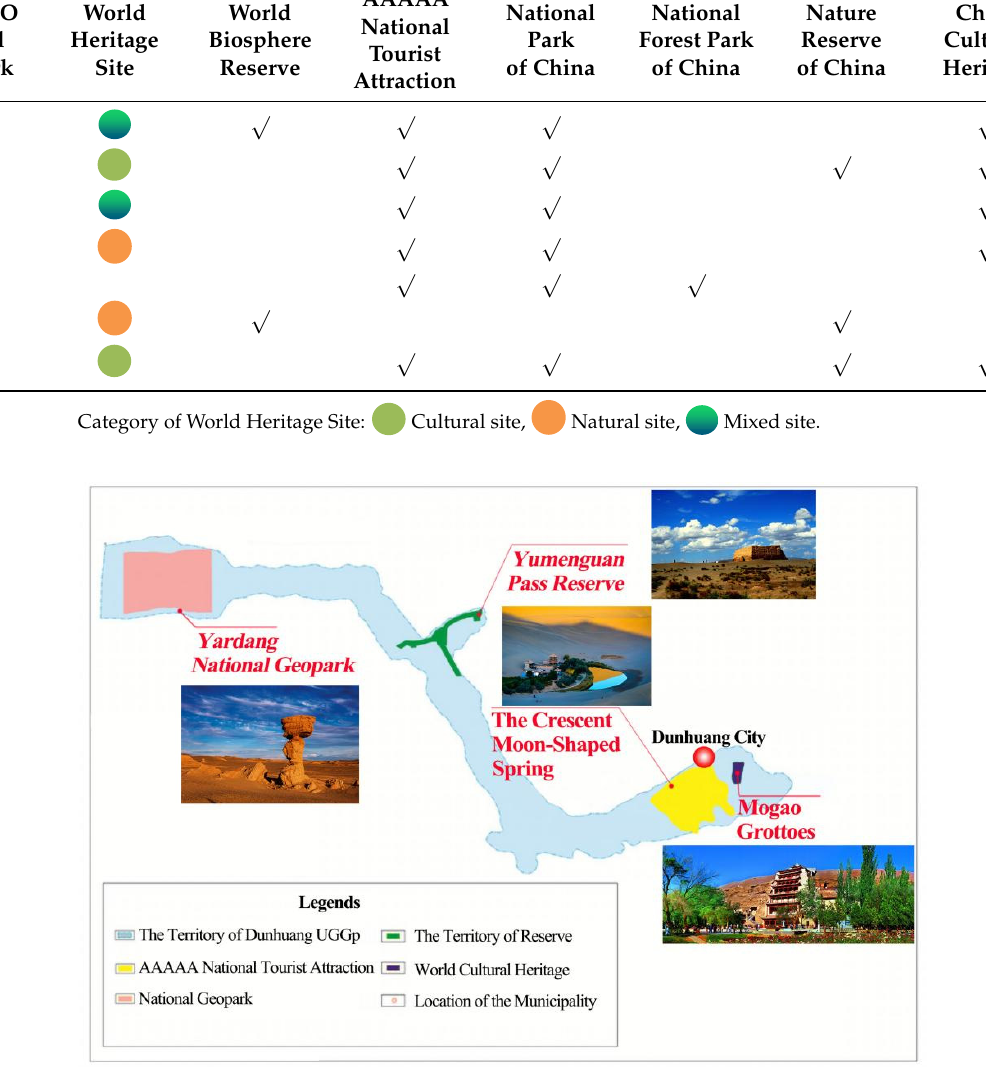
Table 3. Other designations in addition to UGGps (modified from [105]).